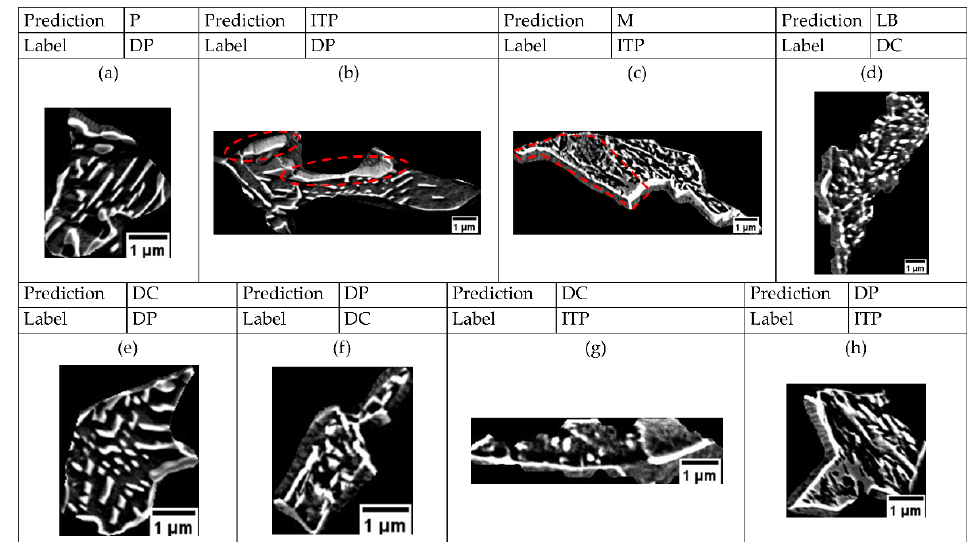
Figure 4. Examples of some misclassifications of the ML model. ( a ) DP classified as P since cementite lamellae are in the transition range from regular to degenerate shape. ( b ) DP classified as ITP as one lamella is cut inclined and appears like M/A. ( c ) ITP classified as M as the M/A part of ITP looks similar to martensite. ( d ) DC classified as LB since the cementite precipitates are arranged similar to those in lower bainite. ( e ) DP classified as DC since cementite lamellae are in the transition range from lamella to debris shape. ( f ) DC classified as DP since cementite particles are in the transition range from lamella to debris shape. ( g ) ITP classified as DC as there are also cementite particles in the ITP object, and the M/A fraction is rather small. ( h ) ITP classified as DC as there are also cementite particles in the ITP object, and the M/A fraction is rather small. ( g ) ITP classified as DP as there are also degenerate cementite lamellae in the ITP object.